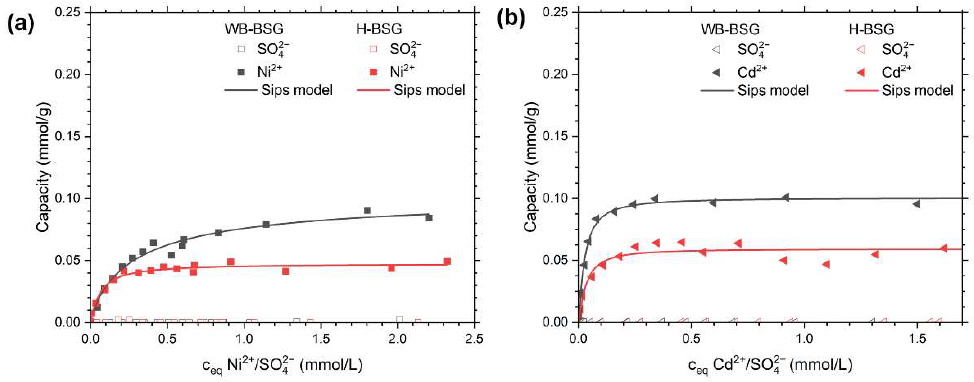
Figure 9. Adsorption isotherms for ( a ) Ni 2+ and ( b ) Cd 2+ onto H-BSG (red) and WB-BSG (grey) obtained from batch experiments with constant BSG dosage (3.33 g/L) and varying initial concentration of NiSO 4 or CdSO 4 for 24 h at r.t. The fitted Sips isotherm model is a solid line and the pH values are in Figures S18 and S21.